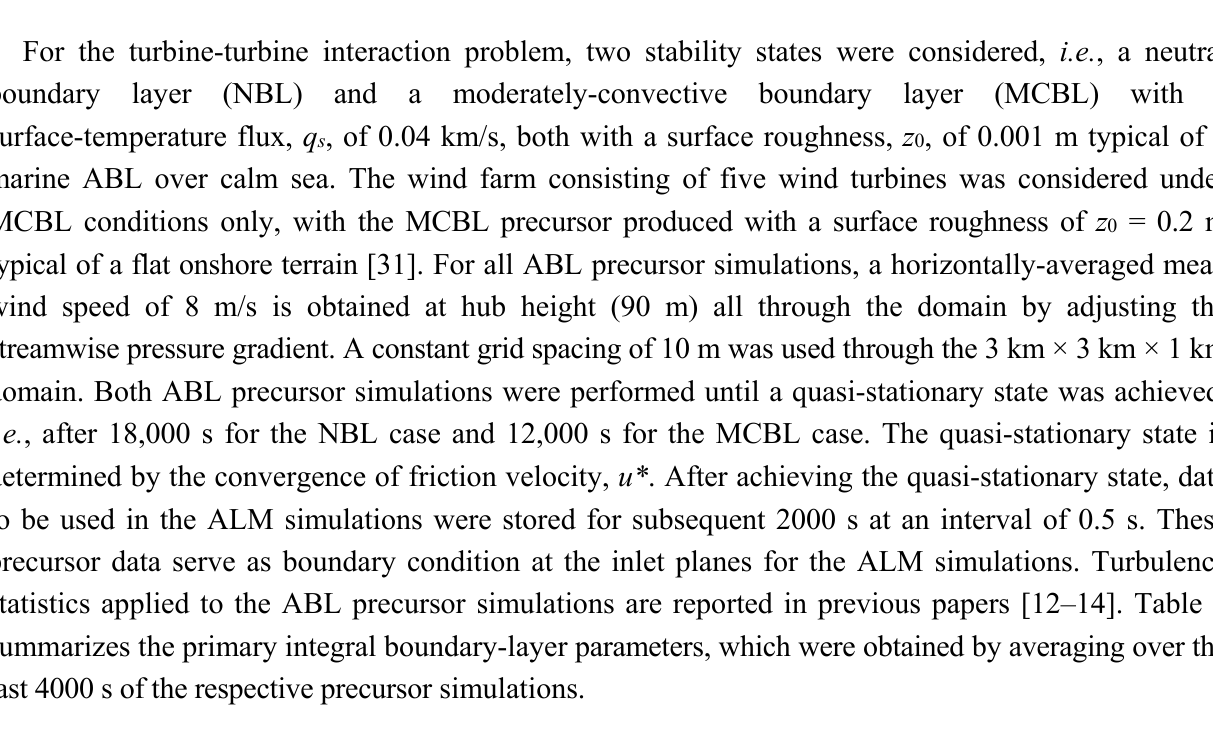
Table 1. Integral boundary-layer parameters of precursor simulations,